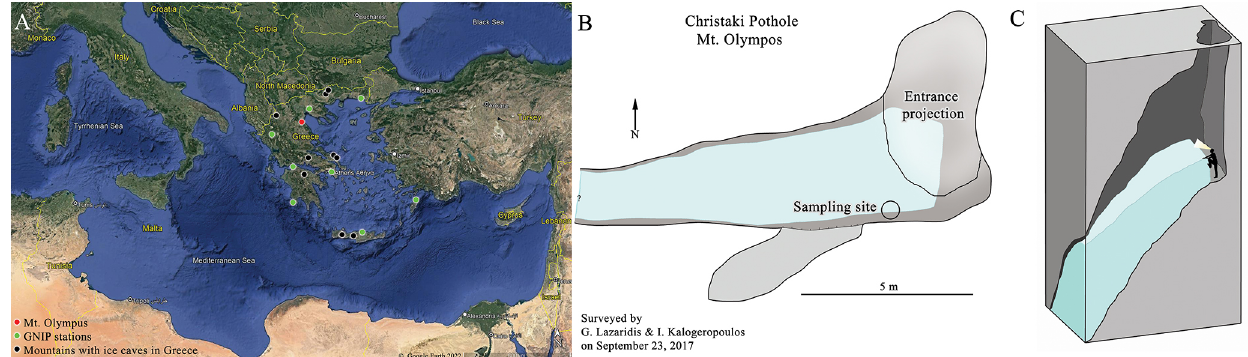
Figure 1. (a) Location of Mt. Olympus and the sampled cave Christaki Pothole; tritium monitoring stations (IAEA/WMO, 2022, and the GNIP (Global Network of Isotopes in Precipitation) database, accessible at https://nucleus.iaea.org/wiser, last access: 21 December 2022) and other mountains of Greece with ice caves (satellite image source from © Google Earth 2022). (b) Ground plan with the sampling site depicted and (c) 3D representation of the cave.